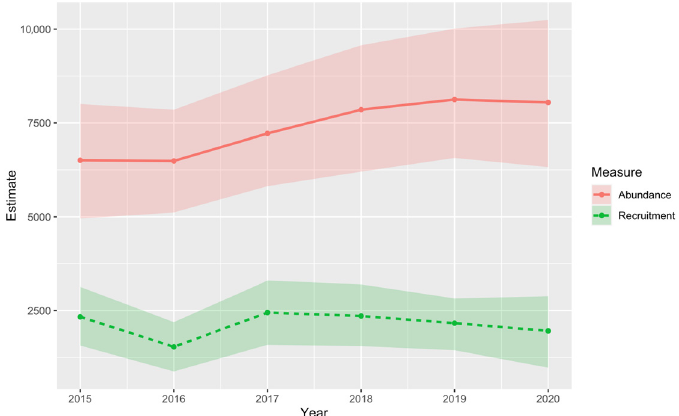
Figure 1. Estimated trends, along with associated 95% confidence intervals (shaded regions), in abundance (top line) and recruitment into the trappable population (bottom line) of North American river otter in Indiana between 2015 and 2020 based on the best available population reconstruction model using particle swarm optimization of an ML objective function.